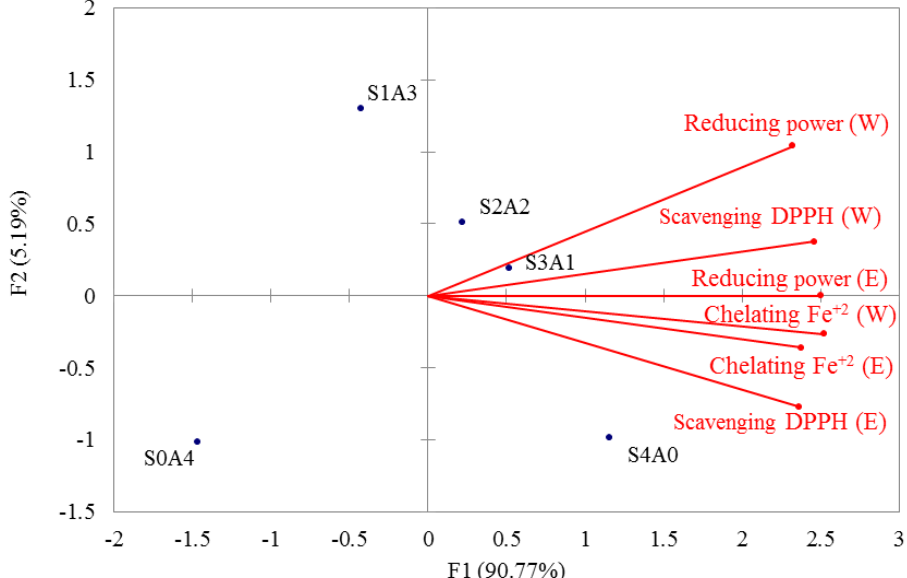
Figure 2. Principal component analysis (PCA) of antioxidant activities of different mycelial products obtained by white truffle solid-state fermentation. Data are expressed as mean ± S.D. ( n = 3). S: soybean, A: red adlay, S4A0 (soybean: red adlay = 4:0), S3A1 (soybean: red adlay = 3:1), S2A2 (soybean: red adlay = 2:2), S1A3 (soybean: red adlay = 1:3), S0A4 (soybean: red adlay = 0:4). W: water, E: ethanol.